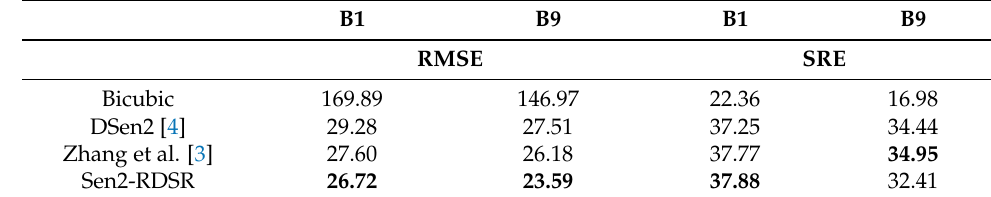
Table 5. Results of the sharpening of 60 m bands (per band).